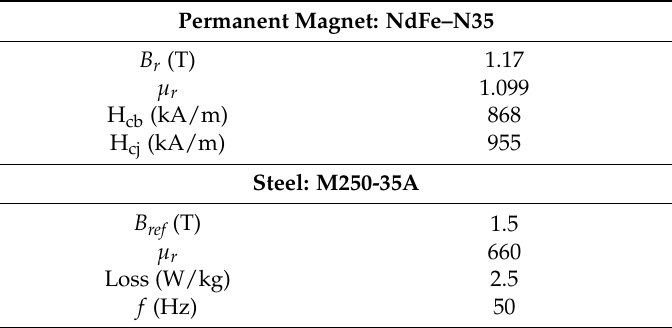
Table 2. Data of the permanent magnet and the